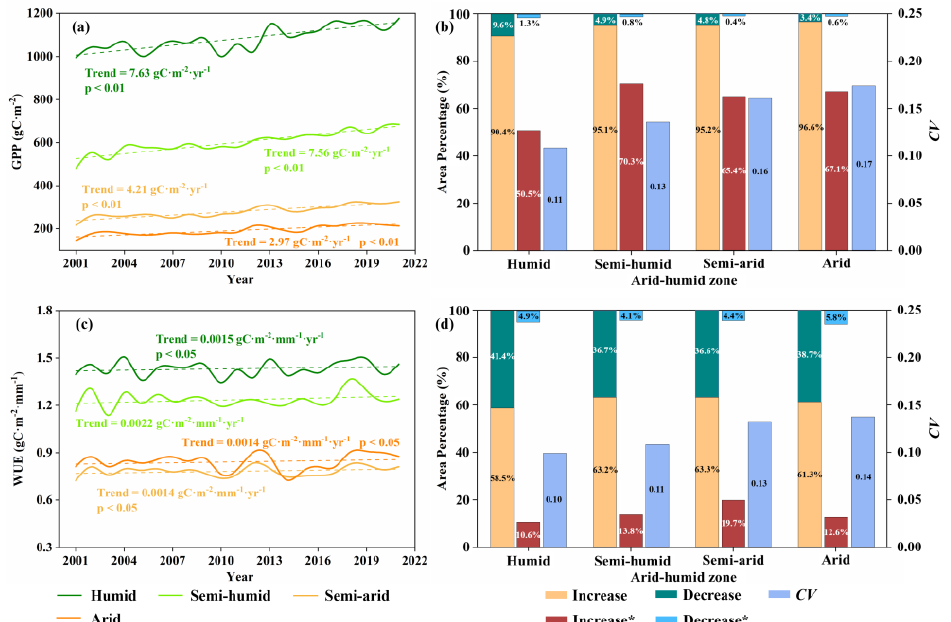
Figure 4. Temporal trends of GPP and WUE for different arid-humid zones across China from 2001 to 2021. ( a , c ) represent the trend of annual average GPP (units: gC · m − 2 · yr − 1 ) and WUE (units: gC · m − 2 · mm − 1 · yr − 1 ) in different arid-humid zones. Significant changes ( p < 0.05) are indicated in the figure. ( b , d ) represent the area percentage with increasing or decreasing trends of GPP and WUE in different arid-humid zones and the average CV values of both. Increased* Decreased*: indicates the change of GPP or WUE reached a significant level ( p < 0.05).